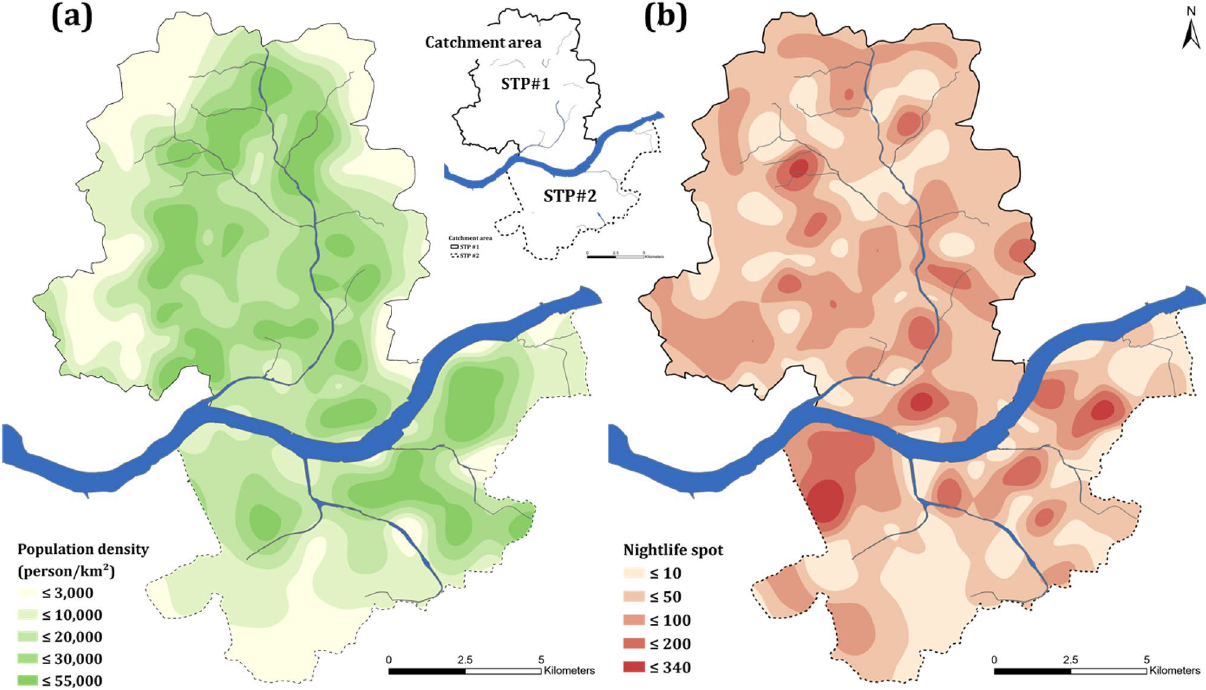
Figure 4. Contour map explaining ( a ) population density (colored green) and ( b ) nightlife spots (colored red) of areas served by STP#1 and STP#2. Geographic data obtained from the National Geographic Information Institute of Korea (http:// map. ngii. go. kr) and processed using ArcGIS Pro (version 2.5; http:// esri. com).